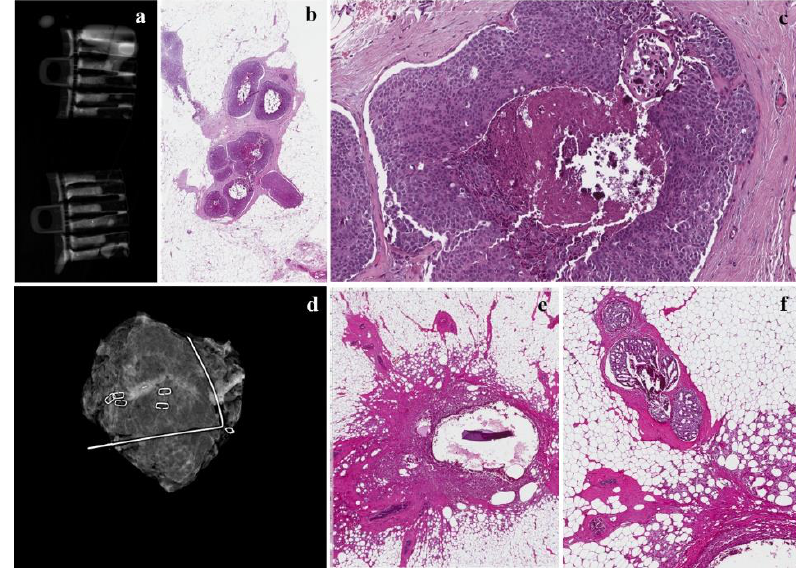
Figure 3. The same case as Figure 3. ( a ) Radiograph during localization of the microcalcification in the samples collected in touch-free collection chambers using the Mammotome Revolve 10 gauge biopsy system that reveals numerous microcalcifications in the cores; ( b , c ) mammotome biopsy